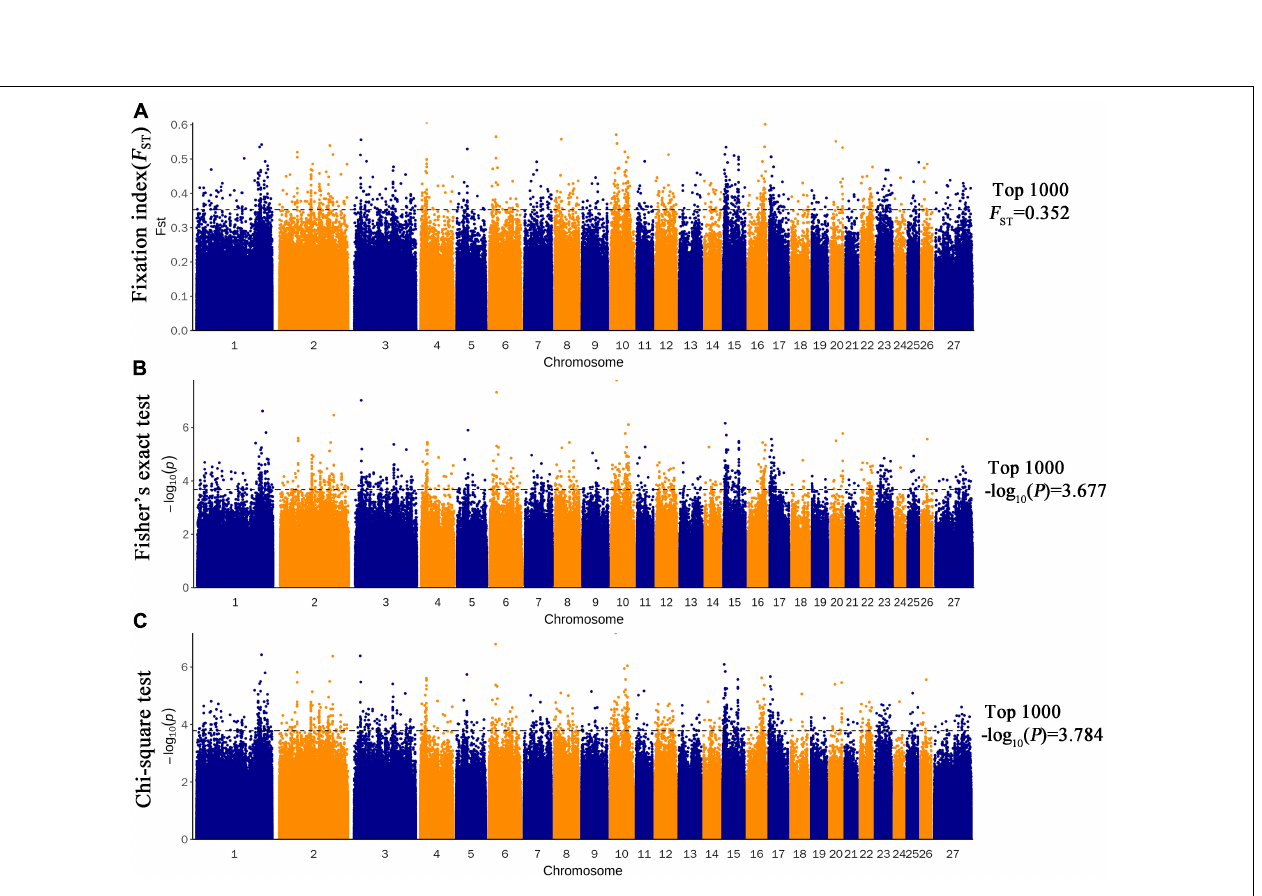
Frontiers in Genetics |